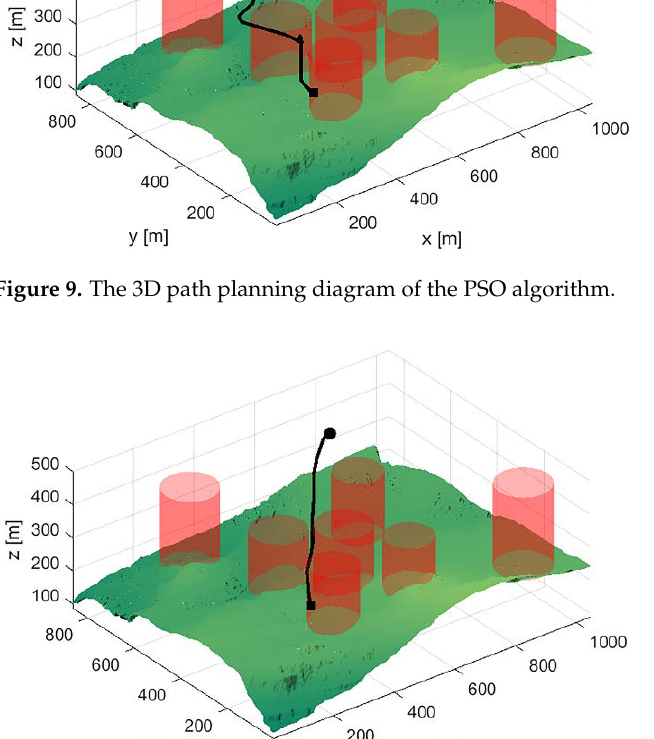
Figure 10. The 3D path planning diagram of the IC-VAINDIWPSO algorithm.